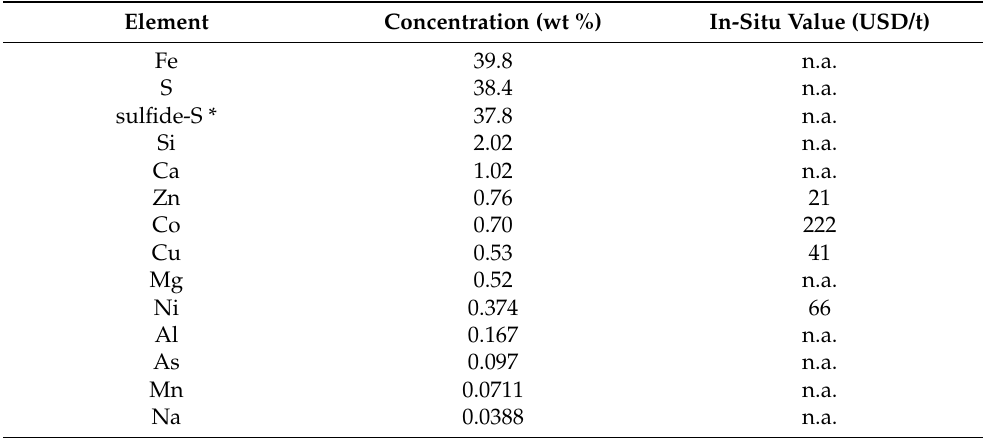
Table 3. Elemental composition of the sulfide concentrate (ICP-OES, except * Eltra). The in situ value was calculated as US dollars per one ton of sulfide concentrate (cash-offer prices on 15 December 2020 by [21]). n.a. = not